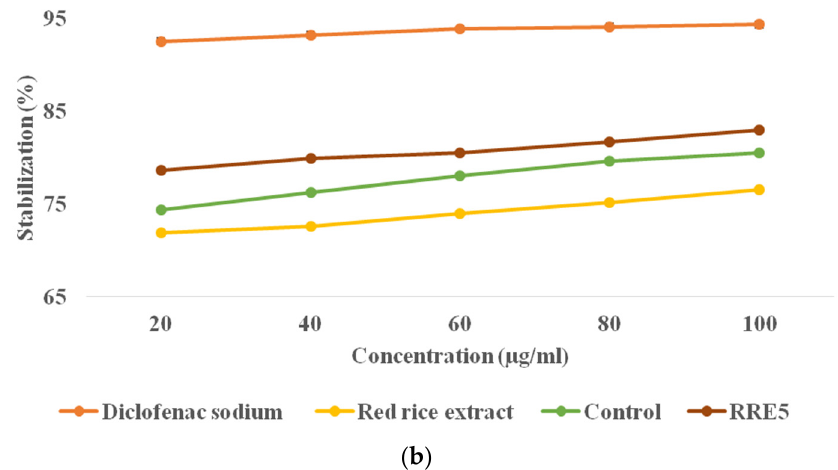
Figure 9. In vitro anti-inflammatory efficiency of red rice extract, control, and RRE5 nanoemulsion by ( a ) protein denaturation and ( b ) HRBC membrane stabilization process. Data are presented as means ± SD ( n = 3).